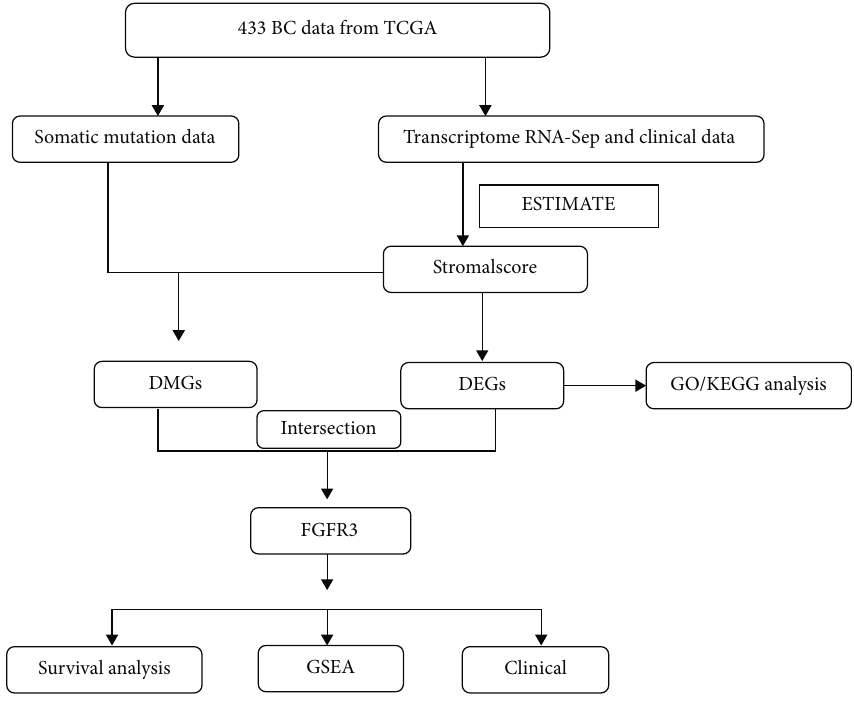
Figure 1: Work fl ow of this